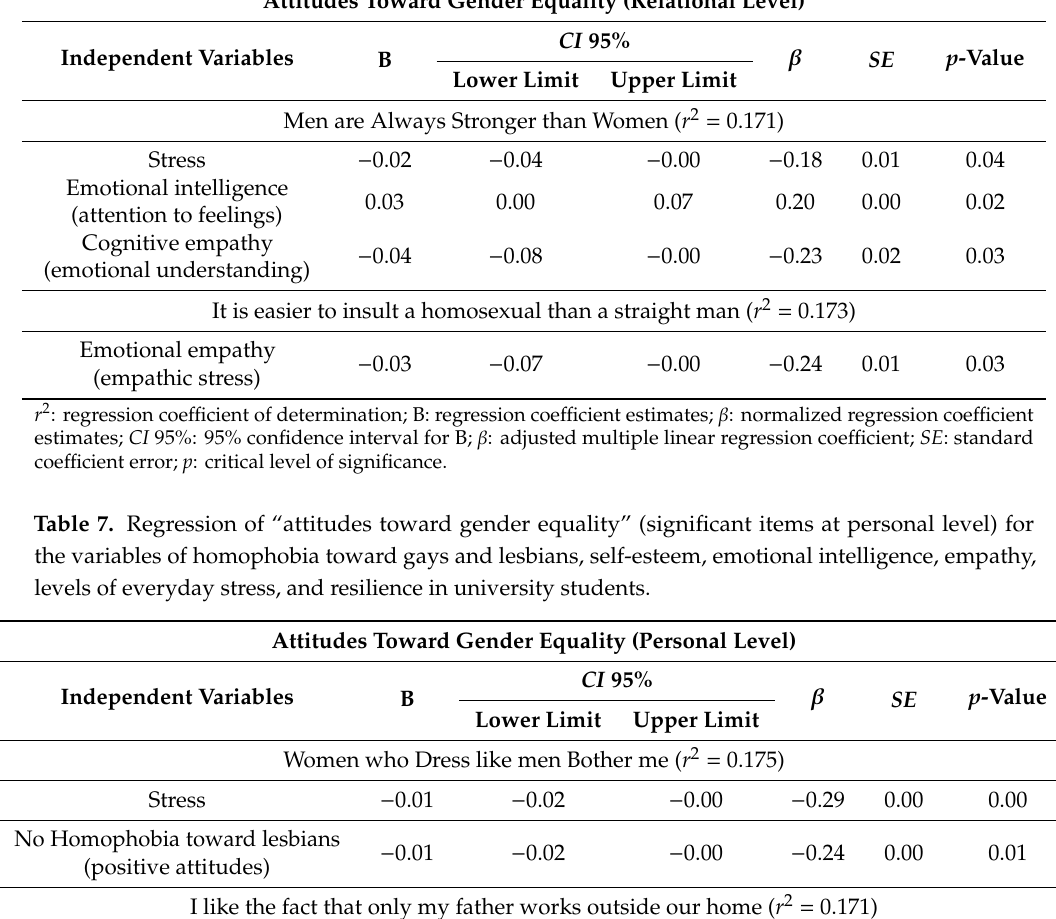
Table 6. Regression of “attitudes toward gender equality” (significant items at relational level) for the variables of homophobia toward gays and lesbians, self-esteem, emotional intelligence, empathy, levels of everyday stress, and resilience in university students.